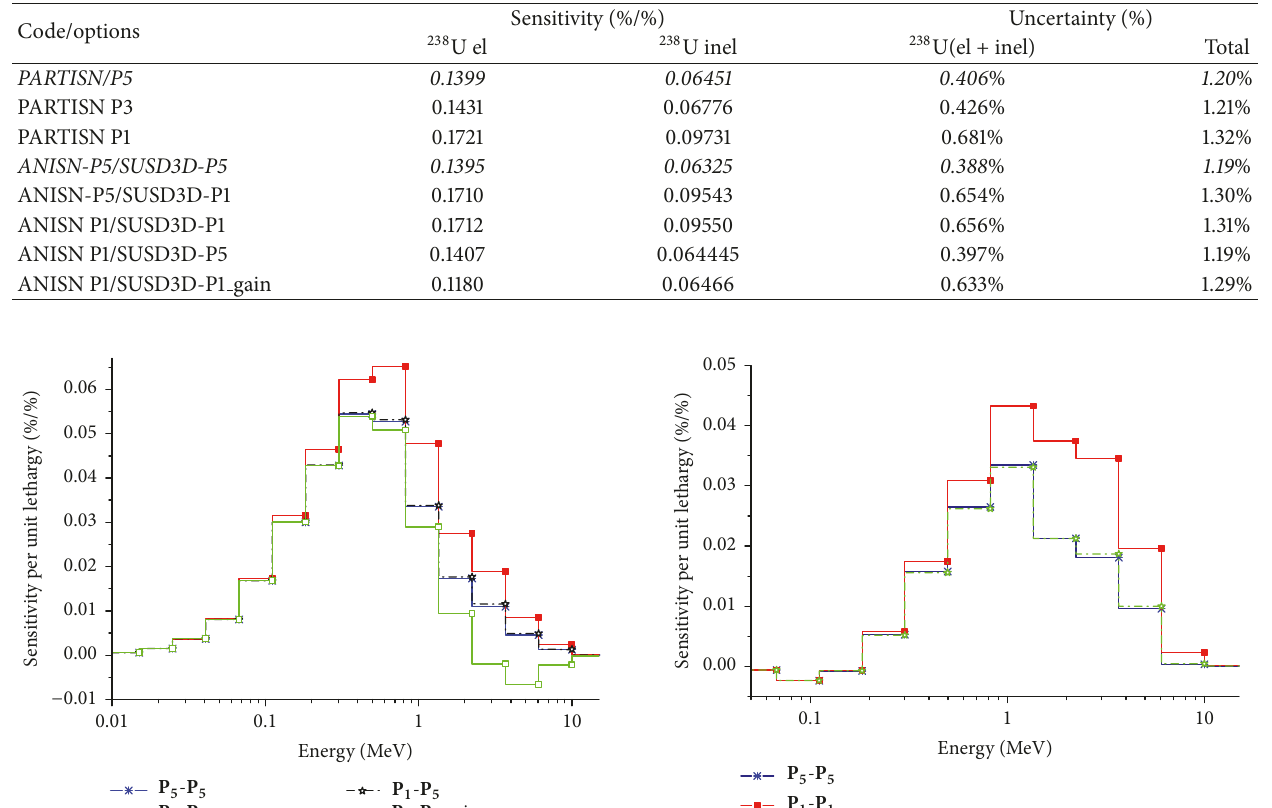
Table 3: Comparison of 𝑘 eff sensitivity and uncertainty results using different approaches.